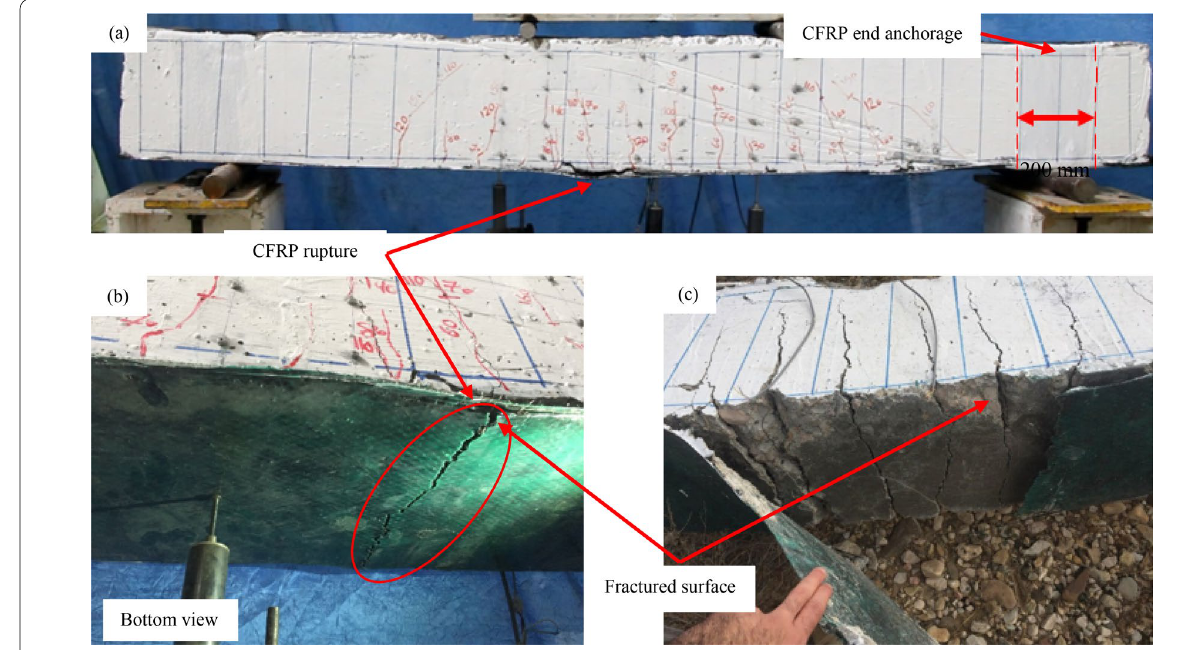
Fig. 11 Failure mechanism and details of failure modes of RCFRP